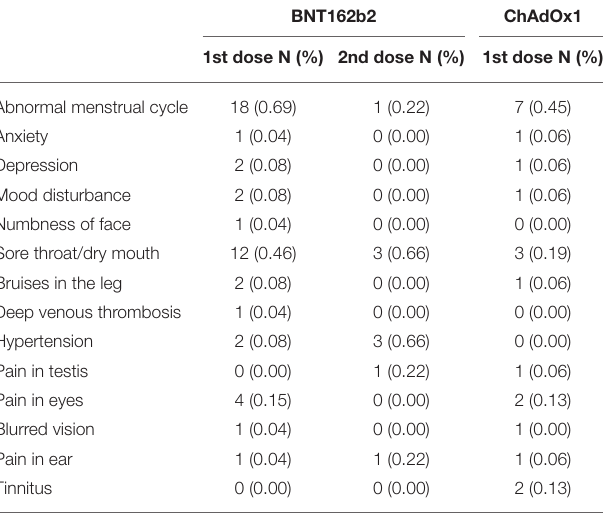
TABLE 6 | Uncommon post-vaccinal adverse effects reported by the participants. BNT162b2